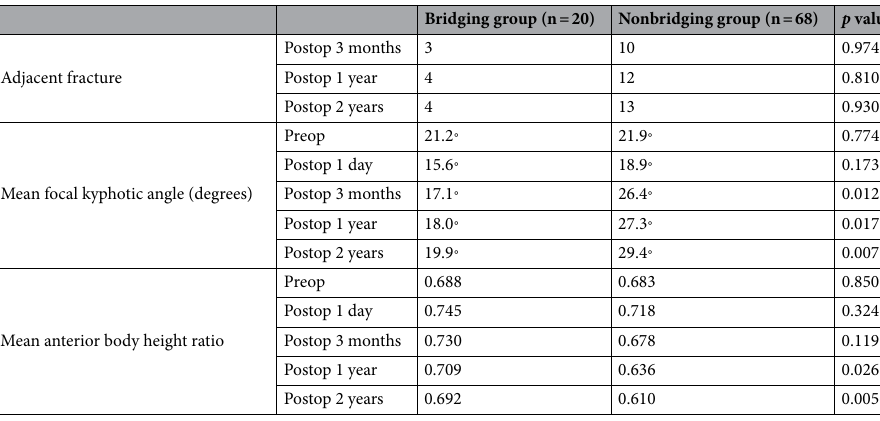
Table 2. Two-year follow-up of the incidence rate of adjacent fractures and radiographic parameters in the bridging and nonbridging groups. Preop preoperative, postop